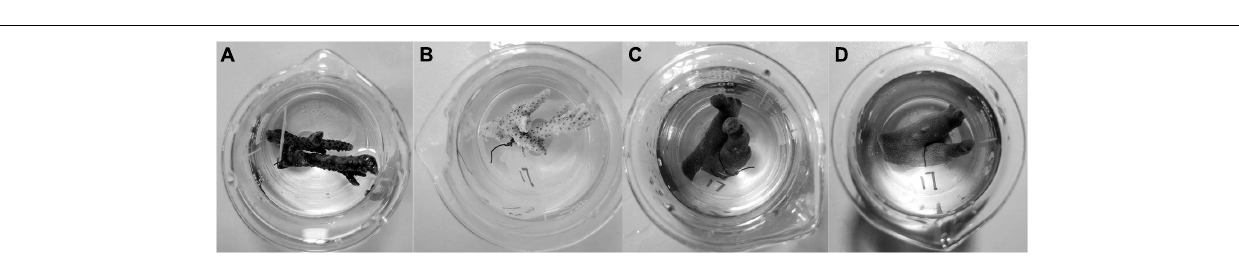
FIGURE 2 | Photographs of representative samples before (A) for A. hyacinthus and (C) for P. cylindrica and after (B) for A. hyacinthus and (D) for P. cylindrica experiments in treatment group 3. The sample of A. hyacinthus in treatment group 3 bleached at the end of the experiment, while no significant color change in P. cylindrica was observed in treatment group